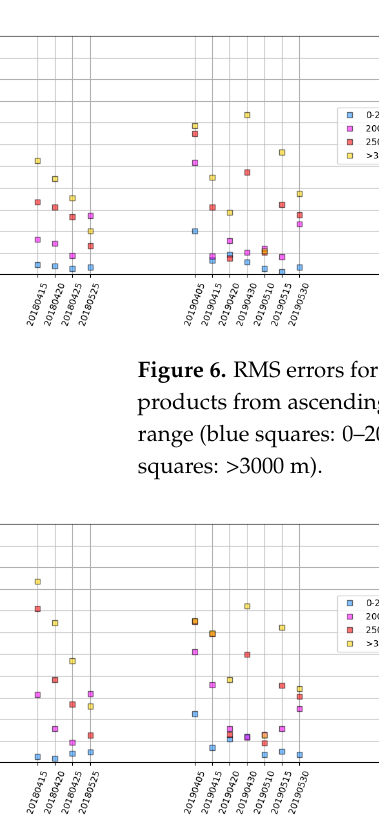
Figure 7. Same as Figure 6 but for the descending orbit.